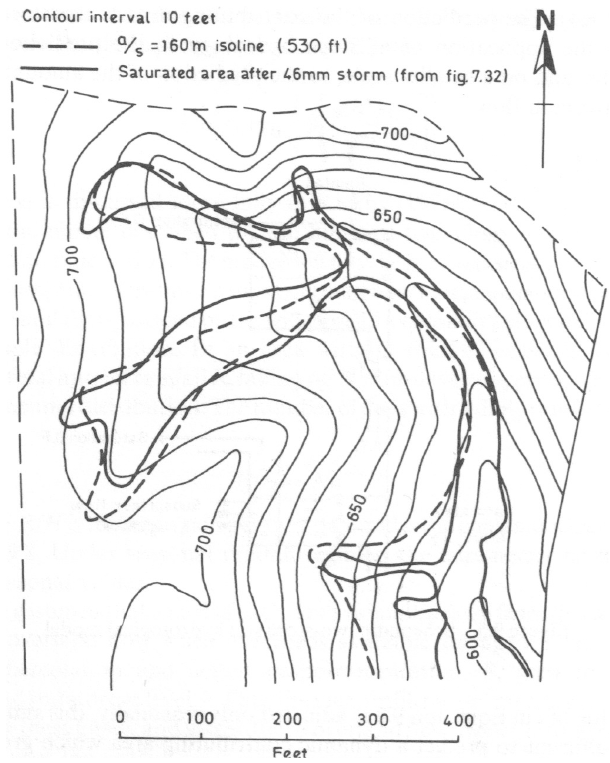
Figure 2. Comparison of the topographic index (a/ tan β) > 160m 2 /m with observed saturated areas after spring snowmelt in the Sleepers River WC-4 catchment, Vermont, USA (from Kirkby, 1978, with permission from